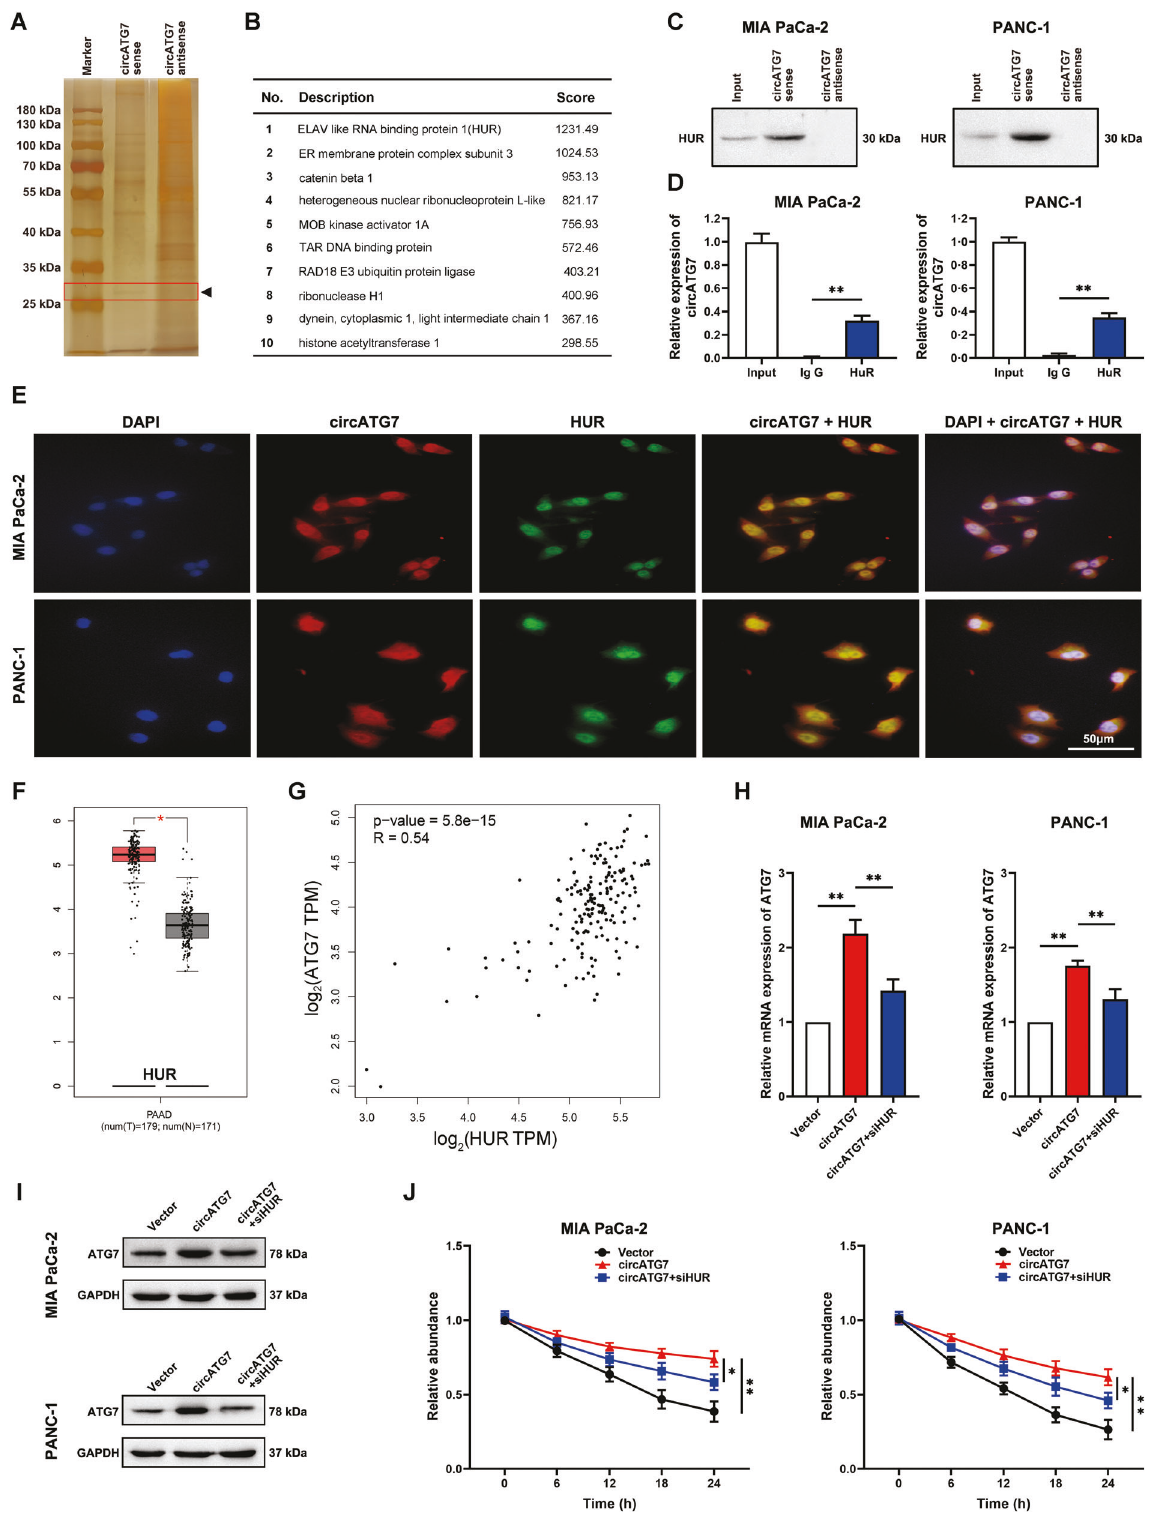
Fig. 6 Nuclear circATG7 increased the stability of ATG7 mRNA by recruiting HUR. A , B RNA pull-down demonstrated that HUR signi fi cantly binds with circATG7. C Western blotting was used to con fi rm the binding of circATG7 with HUR. D HUR antibodies were used to evaluate circATG7 enrichment. E Confocal experiments were used to observe the co-localization of circATG7 and HUR in the cell nucleus. F Expression of HUR in PC tissues and adjacent normal tissues based on the data from TCGA. G The relationship between circATG7 and HUR was determined according to the data from TCGA. H , I ATG7 expression was detected using RT-qPCR and western blotting in PC tissues with circATG7 overexpression plus HUR inhibition. J The stability of ATG7 mRNA was evaluated in PC cells with circATG7 overexpression plus HUR inhibition. * P < 0.05; ** P <